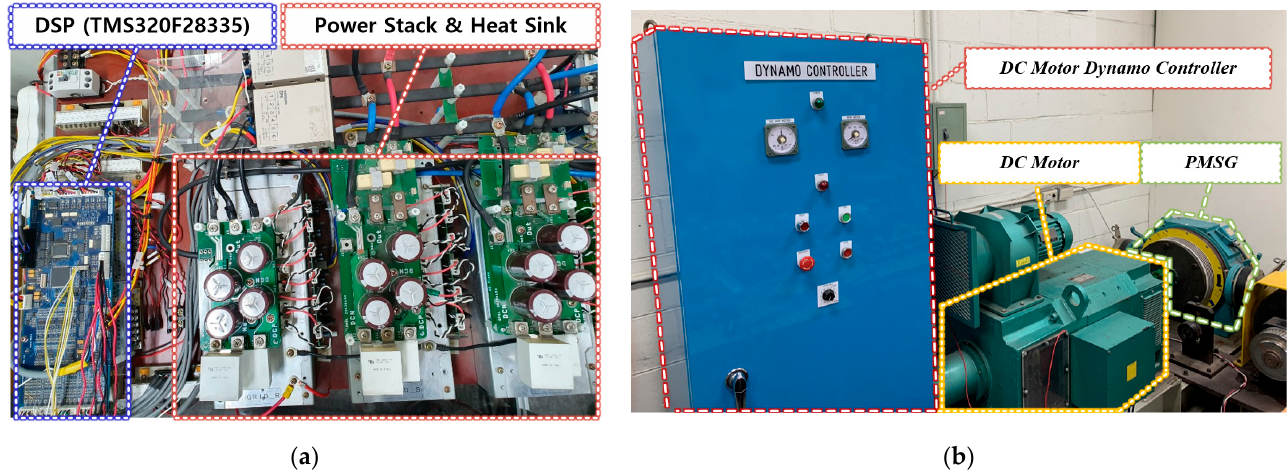
Figure 19. Configuration of the wind generation system hardware set ( a ) 3-level NPC, ( b ) MG-set.